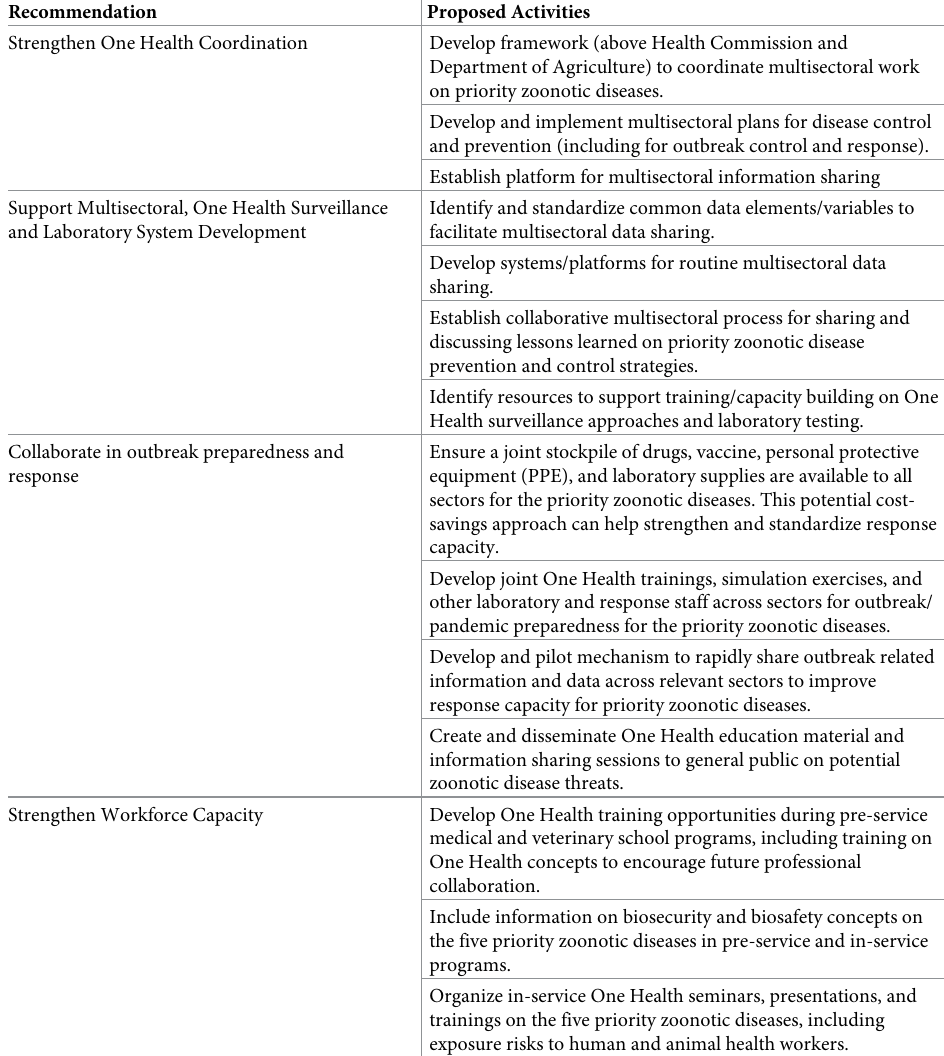
Table 4. Recommendations and next steps identified by workshop participants for improving the control and pre- vention of the top five priority zoonotic diseases in China. The priority zoonotic diseases for China include avian influenza, echinococcus, rabies, plague, and